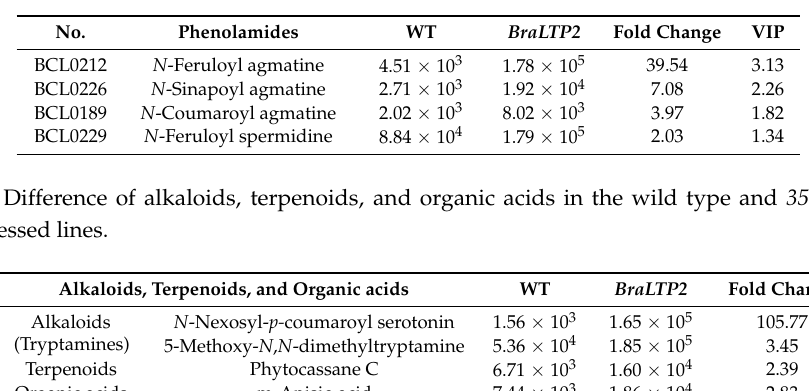
Table 5. Difference of phenolamides in the wild type and 35::BraLTP2- overexpressed lines.